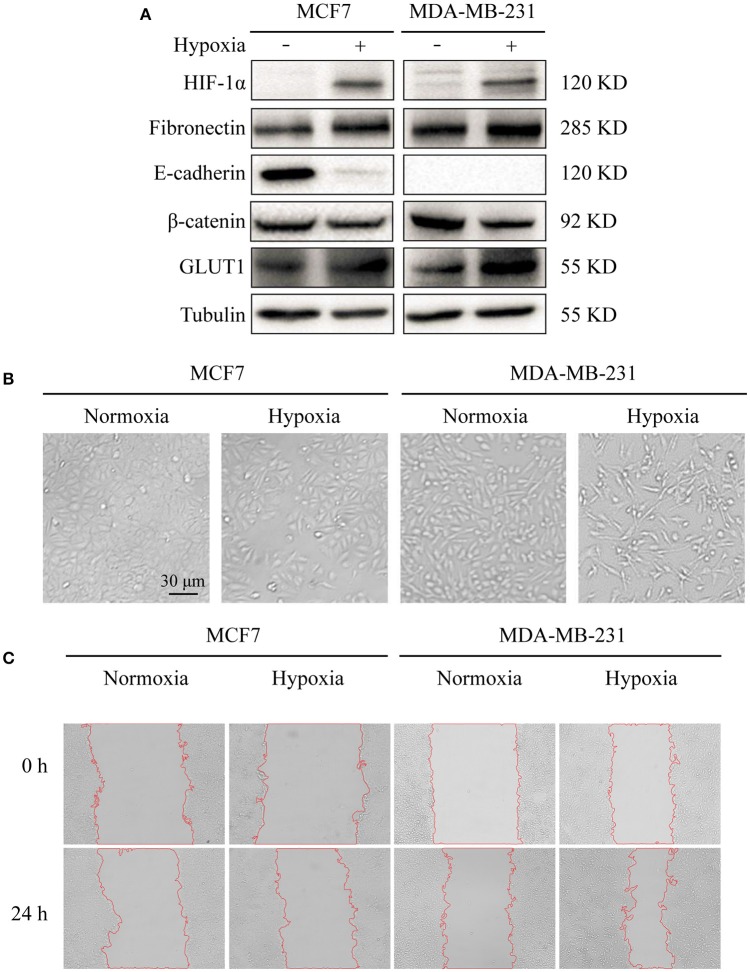
Effects of hypoxia on cell markers, morphology, and migration (A) Expression in breast cancer MCF7 and MDA-MB-231 cells of E-cadherin (epithelial marker), fibronectin (epithelial marker), HIF-1α (hypoxia marker), β-catenin, and GLUT1. Cells were cultured at 37°C in 5% CO2 atmosphere for normoxic treatment, and in 1% O2/ 5% CO2/ 94% N2 atmosphere for hypoxic treatment. Cells were harvested, lysed in T-PER Reagent, and protein content was determined by BCA assay. Western blotting was performed as described in M&M. (B) Morphological changes under normoxic and hypoxic conditions. Cells (2 × 105 per well) were grown in 6-well plates for 24 h under the two conditions. Photos were taken by phase-contrast microscopy at 200× magnification. (C) Cell migration assessed by wound assay. Cell monolayers under the two conditions were scratched with pipette tip. Cells were washed with ice-cold 1× PBS and cultured in serum-free medium. Pictures of wounds were taken at 0 and 24 h by phase-contrast microscopy (100× magnification).